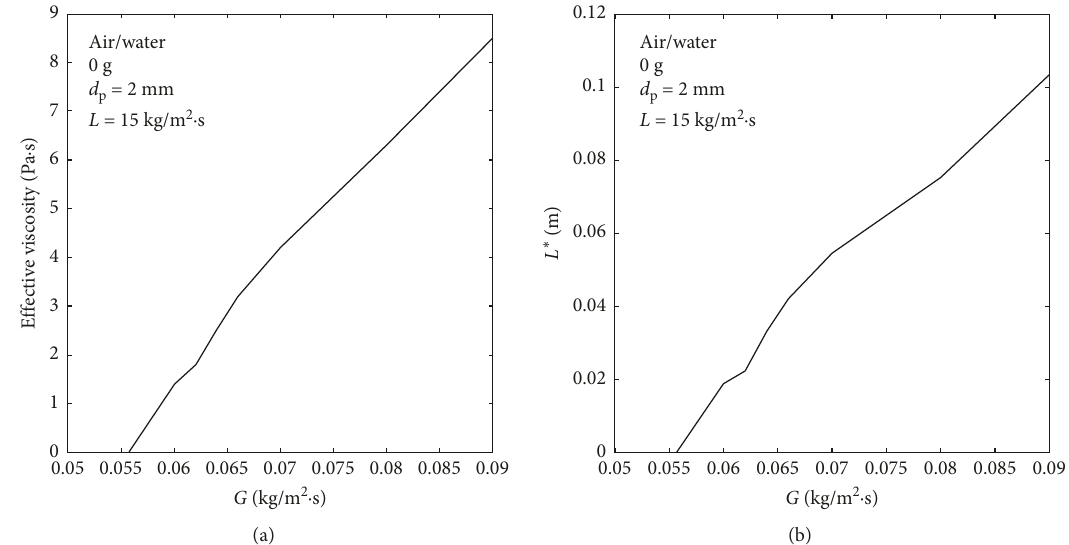
Figure 8: (a) Evolution of the effective viscosity as the gas flow rate is increased beyond the bubble-to-pulse transition. (b) Evolution of the characteristic length L as the gas flow rate is increased beyond the bubble-to-pulse ∗